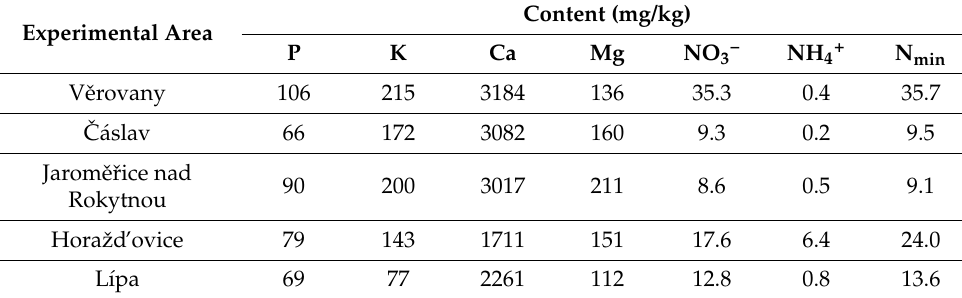
Table 2. The soil content of macronutrients before sowing (October of